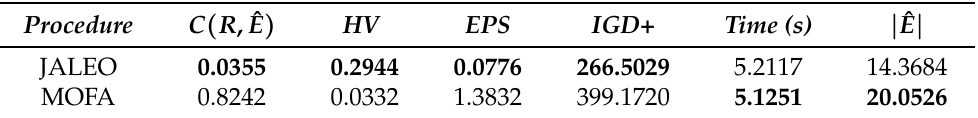
Table 4. Comparison between the best configuration for the JALEO and MOFA constructive proce-